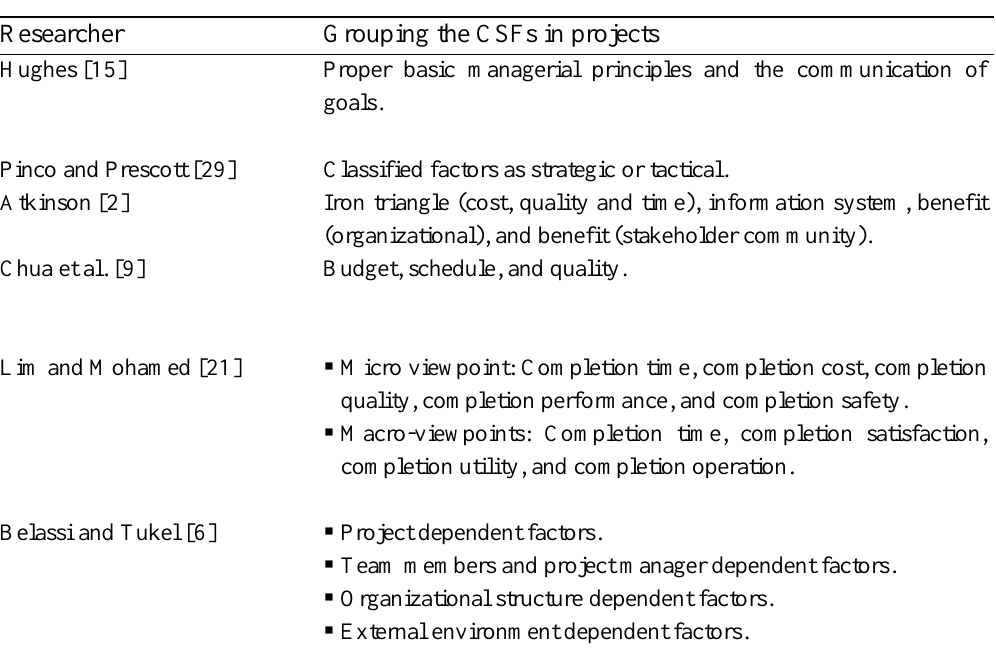
Table 1. Literature of Identifying CSFs in